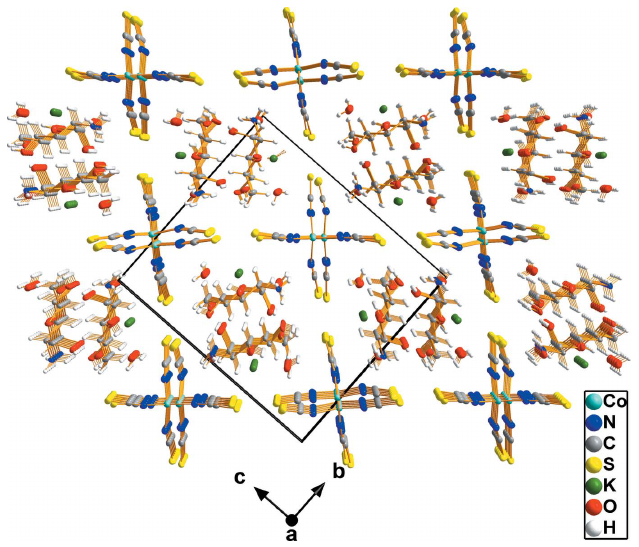
Figure 4 The packing of the ions in the crystal structure of the title